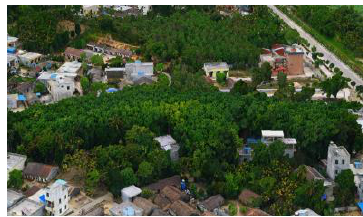
Figure 11. 3D visualization of Rural residential